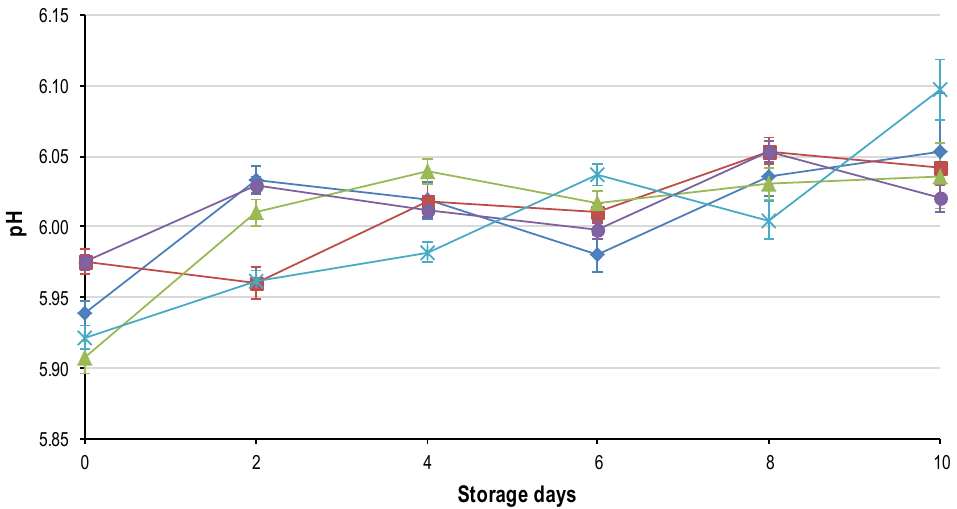
Storage days Figure 2. Average cooking loss (±std. error) for the five characteristic freezing rates: FR_1h (  ); FR_2h Figure 2. Average cooking loss (±std. error) for the five characteristic freezing rates: FR_1h (  ); FR_2h Figure 3. Average pH ( ± std. error) for the five characteristic freezing rates: FR_1h ( (cid:7) ); FR_2h ( (cid:4) ); Figure 2. Average cooking loss (±std. error) for the five characteristic freezing rates: FR_1h (  ); FR_2h Figure 3. Average pH (±std. error) for the five characteristic freezing rates: FR_1h (  ); FR_2h (  ); (  ); FR_4h (  ); FR_8h (  ) and FR_24h (  ) over the 10-day shelf-life trial at ±4 °C. (  ); FR_4h (  ); FR_8h (  ) and FR_24h (  ) over the 10-day shelf-life trial at ±4 °C. ) over the 10-day shelf-life trial at ± 4 ◦ FR_4h (  ); FR_8h (  ) and FR_24h (  ) over the 10-day shelf-life trial at ±4 °C.